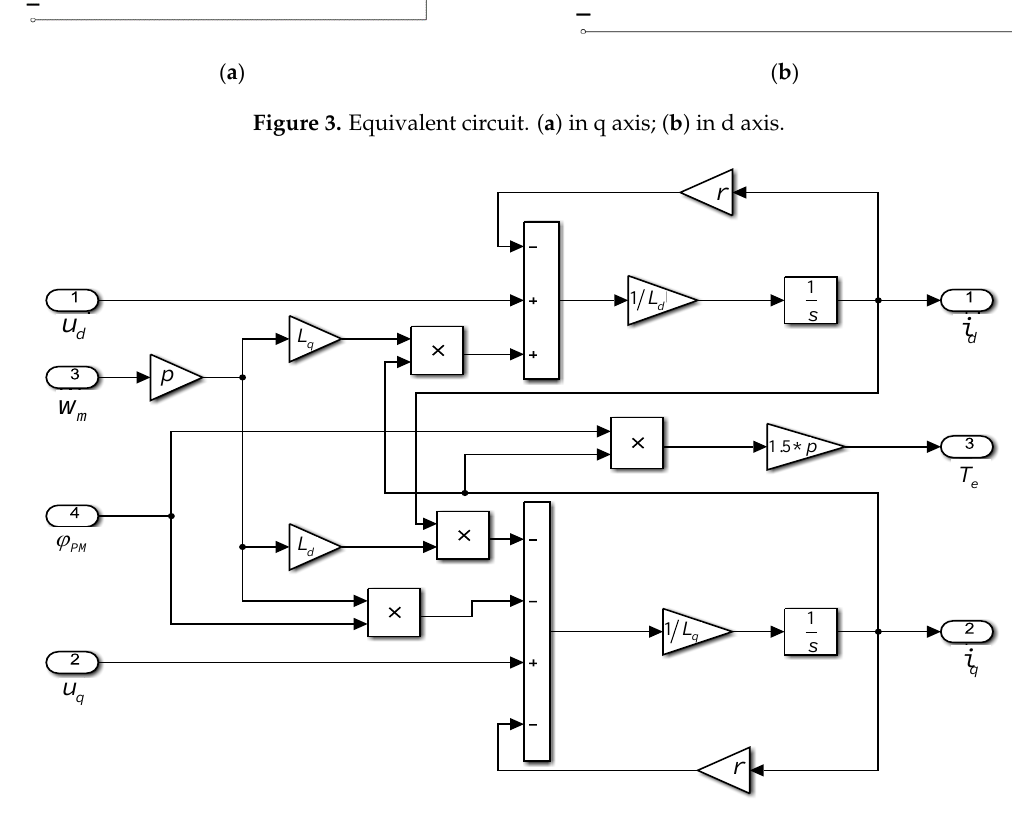
Figure 4. Dynamic model of the proposed AFPMSG.